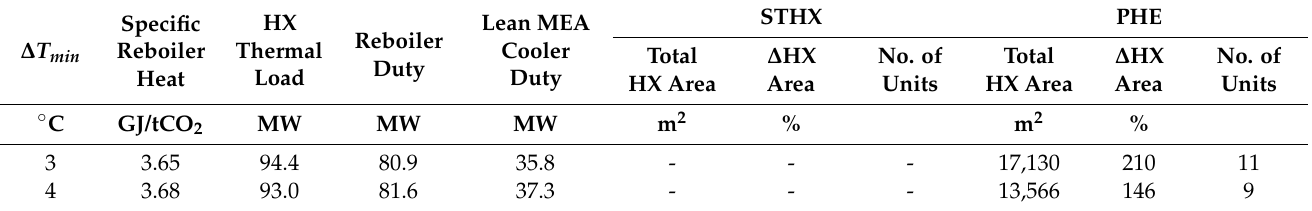
Table 11. The influence of the lean/rich heat exchanger ∆ T min on the thermal load and area of the required heat exchangers (cement plant standard CO 2 capture